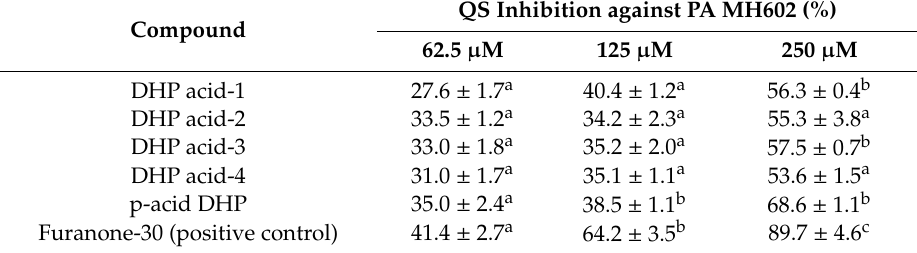
Table 4. QS inhibition activity (%) against P. aeruginosa MH602 lasB reporter strain at di ff erent concentrations of DHP derivatives; a growth inhibition ≤ 10%; b growth inhibition 11%–30%; growth inhibition >